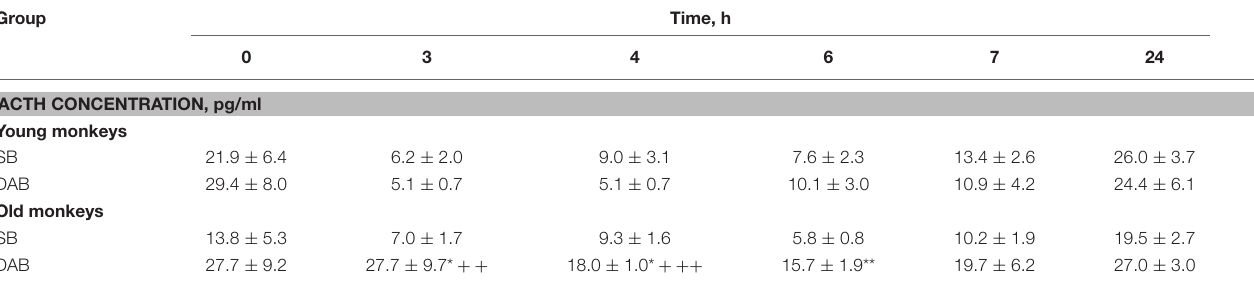
TABLE 1 | Dynamics of ACTH concentration in peripheral blood plasma of young and old female rhesus monkeys with SB and DAB in response to administration of placebo (mean ± S.E.M.). Group Time, h 0 3 4 6 7 24 ACTH CONCENTRATION, pg/ml Young monkeys SB 21.9 ±